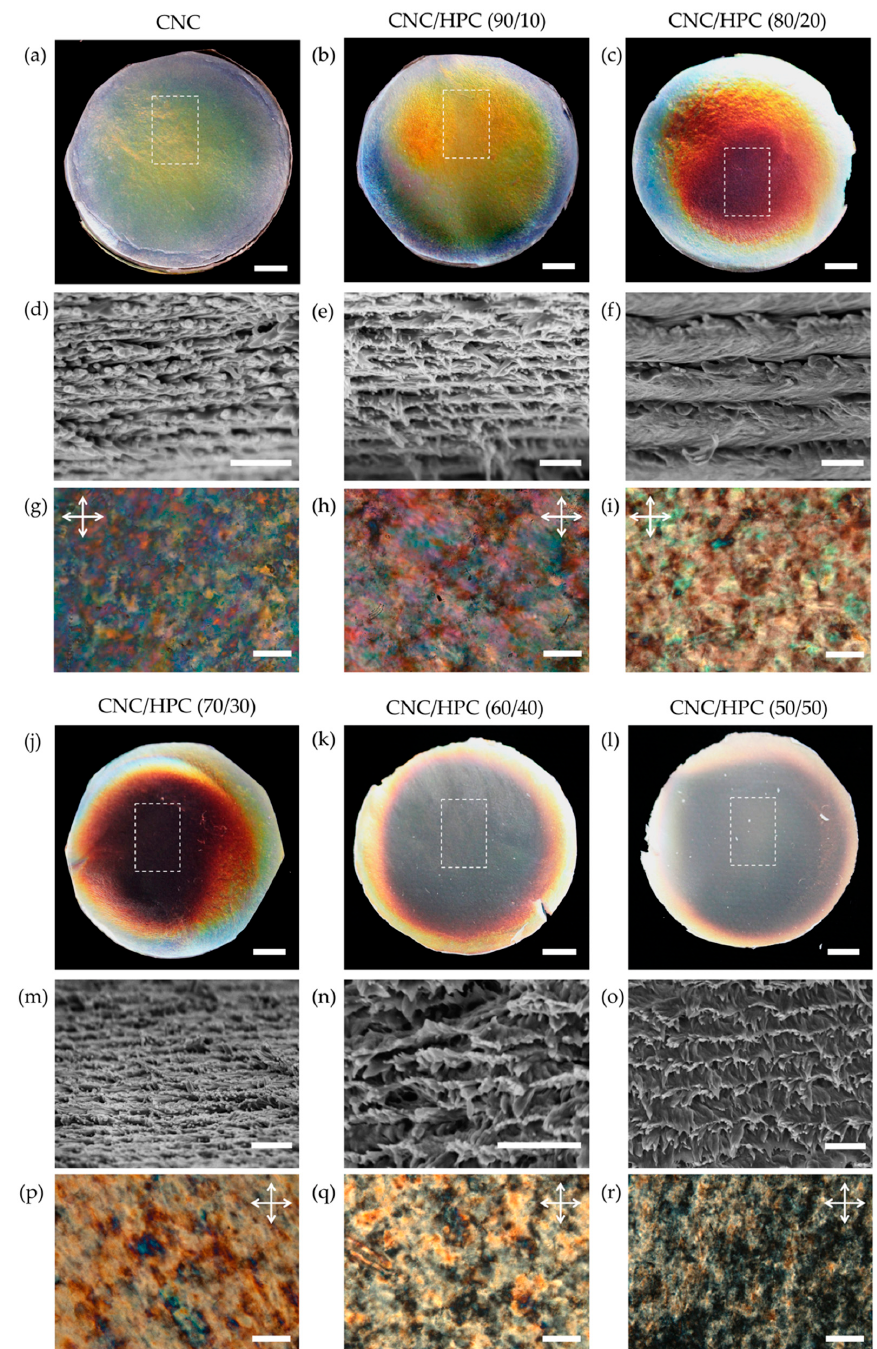
Figure 3. (a–c,j–l) Photographs of neat CNCs and CNC/HPC films with different content of HPC taken under uncollimated unpolarised white light; (d–f,m–o) SEM images of the central region of the cross-section of the CNCs and CNC/HPC films, where the chiral nematic arrangement can be observed; (g–i,p–r) POM images obtained with crossed-polars and in transmission mode of the central regions of neat CNCs and CNCs/HPC films. Scale bars: (a–c and j–l) 5 mm, (d–f) 500 nm, (m–o) 1 μ m, (g–i and p–r) 100 μ m. POM images. In the photographs, a dashed white rectangle was added that marks the area observed with the UV / VIS / IR